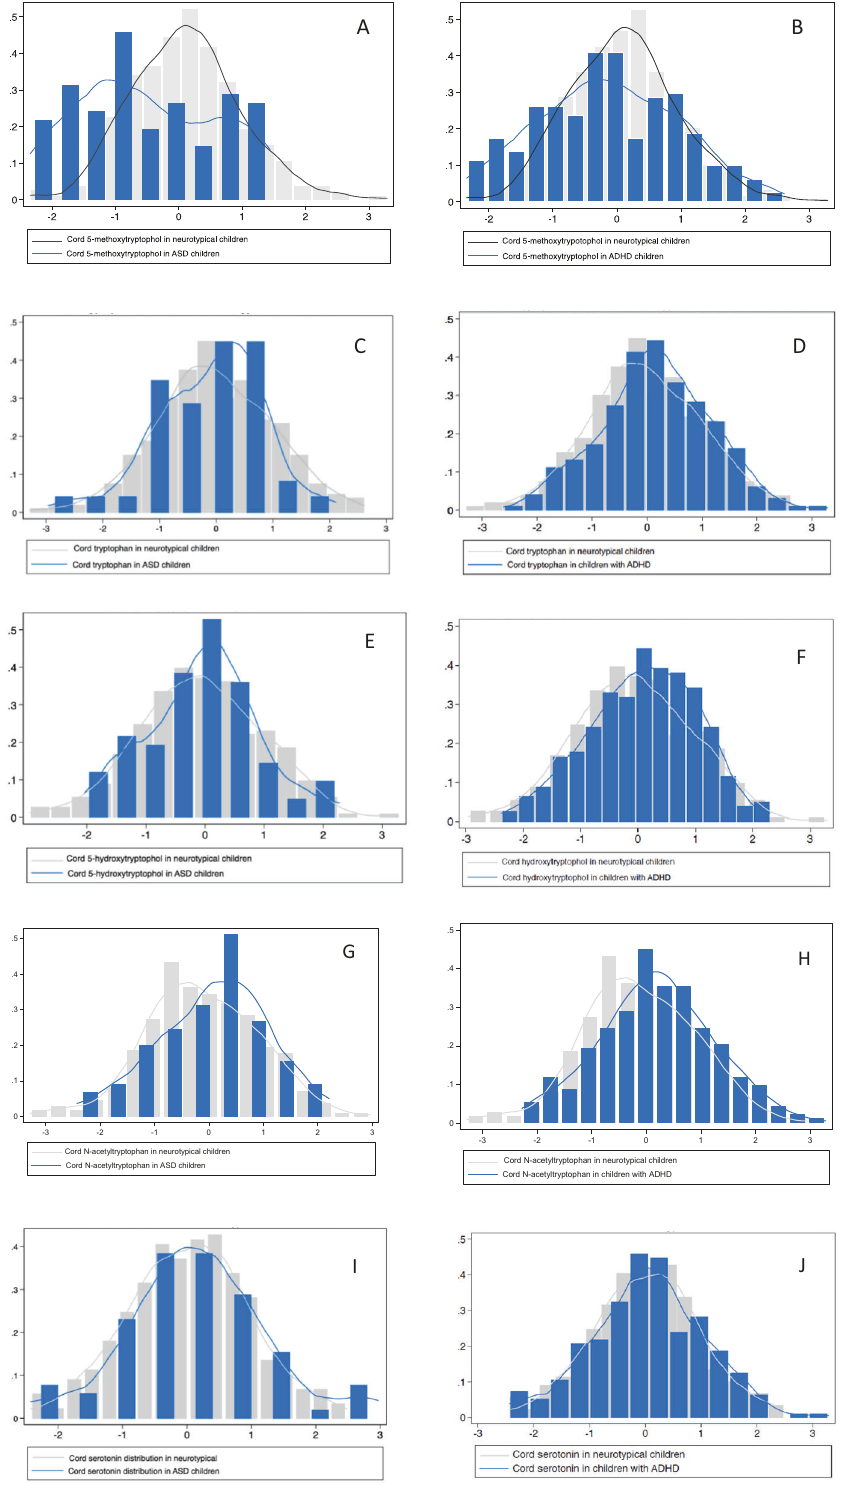
Fig. 2 Distribution of cord tryptophan and its selected metabolites among those with ASD, ADHD, and other DD. A Cord 5-methoxytryptophol distribution in neurotypical and ASD children. B Cord 5-methoxytryptophol distribution in neurotypical and ADHD children. C Cord tryptophan distribution in neurotypical and ASD children. D Cord tryptophan distribution in neurotypical and ADHD children. E Cord 5-hydroxytryptophol distribution in neurotypical and ASD children. F Cord 5-hydroxytryptophol distribution in neurotypical and ADHD children. G Cord N-acetyltryptophan distribution in neurotypical and ASD children. H Cord N-acetyltryptophan distribution in neurotypical and ADHD children. I Cord serotonin distribution in neurotypical and ASD children. J Cord serotonin distribution in neurotypical and ADHD children. ASD autism spectrum disorder, ADHD attention-de fi cit/hyperactivity disorder.